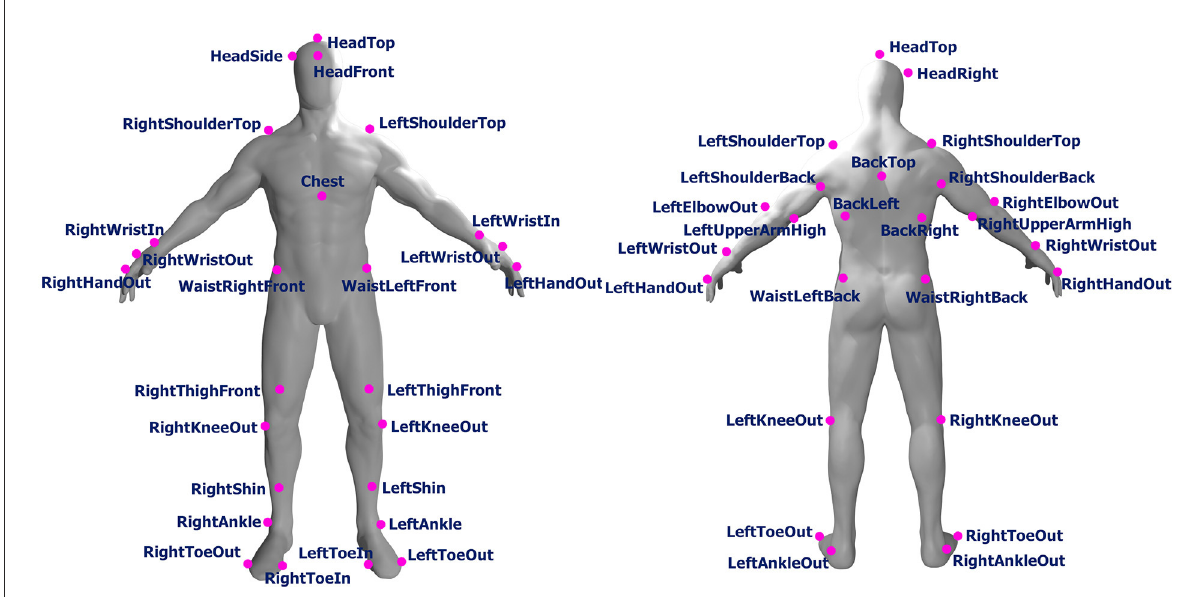
FIGURE1 Position of front and back markers (original human figure source: dox012 on Sketchfab 1 ).